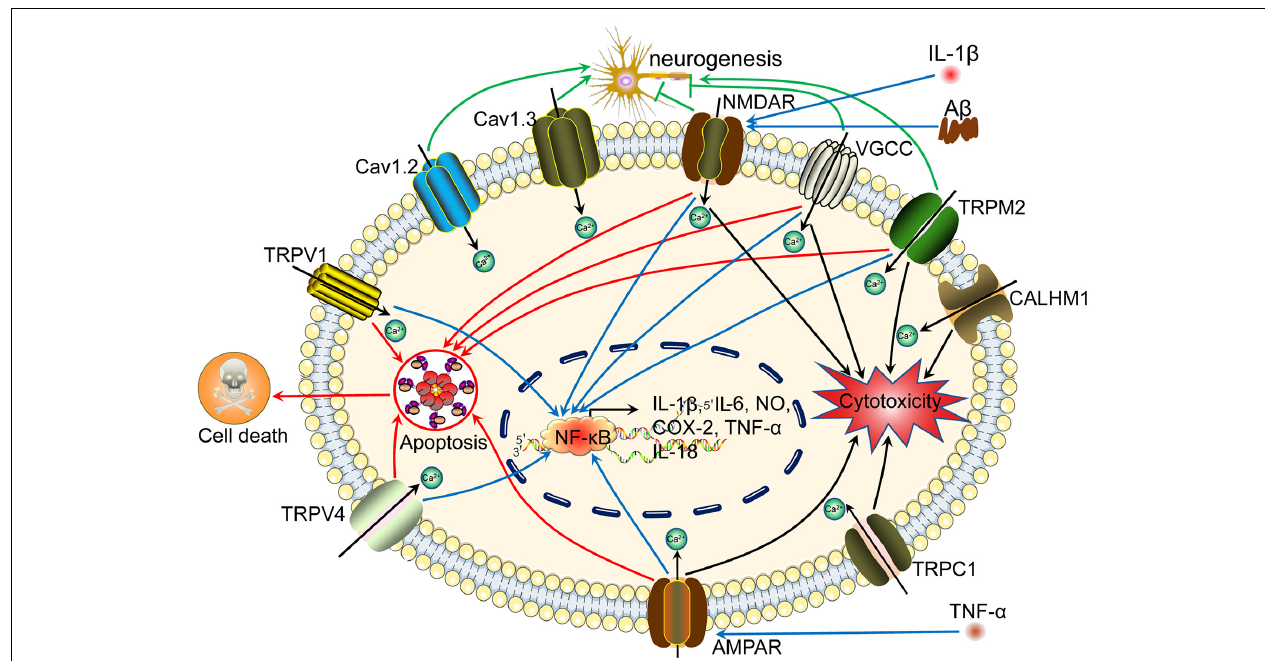
FIGURE 1 | Ca 2+ participates in regulating neuroinflammation, neuronal injury, neurogenesis, neurotoxicity, neuroprotection, autophagy and apoptosis via its transporters located on the cell membrane. A β activates Ca 2+ transporters, including NMDAR, AMPAR, LTCC, Na + /K + -ATPase, CALHM1, TRPV1, and Cav1.2, which promote Ca 2+ entry into the cytoplasm and increase the concentration of Ca 2+ in neuronal cells. More importantly, these Ca 2+ transporters mediate the effects of Ca 2+ on neuroinflammation, neuronal injury, neurogenesis, neurotoxicity, neuroprotection, autophagy, and apoptosis through different mechanisms. A β activates NMDAR, LTCC, CALHM1, and TRPV1, which result in apoptosis induction, leading to cell death. Regarding neuroinflammation, NMDARs mediate the effects of A β on activating NF- κ B through a Ca 2+ -dependent mechanism, which results in transcriptional regulation of the secretion of IL-1 β , IL-6, NO, and TNF- α . Moreover, NMDARs induce LC3 II production, leading to